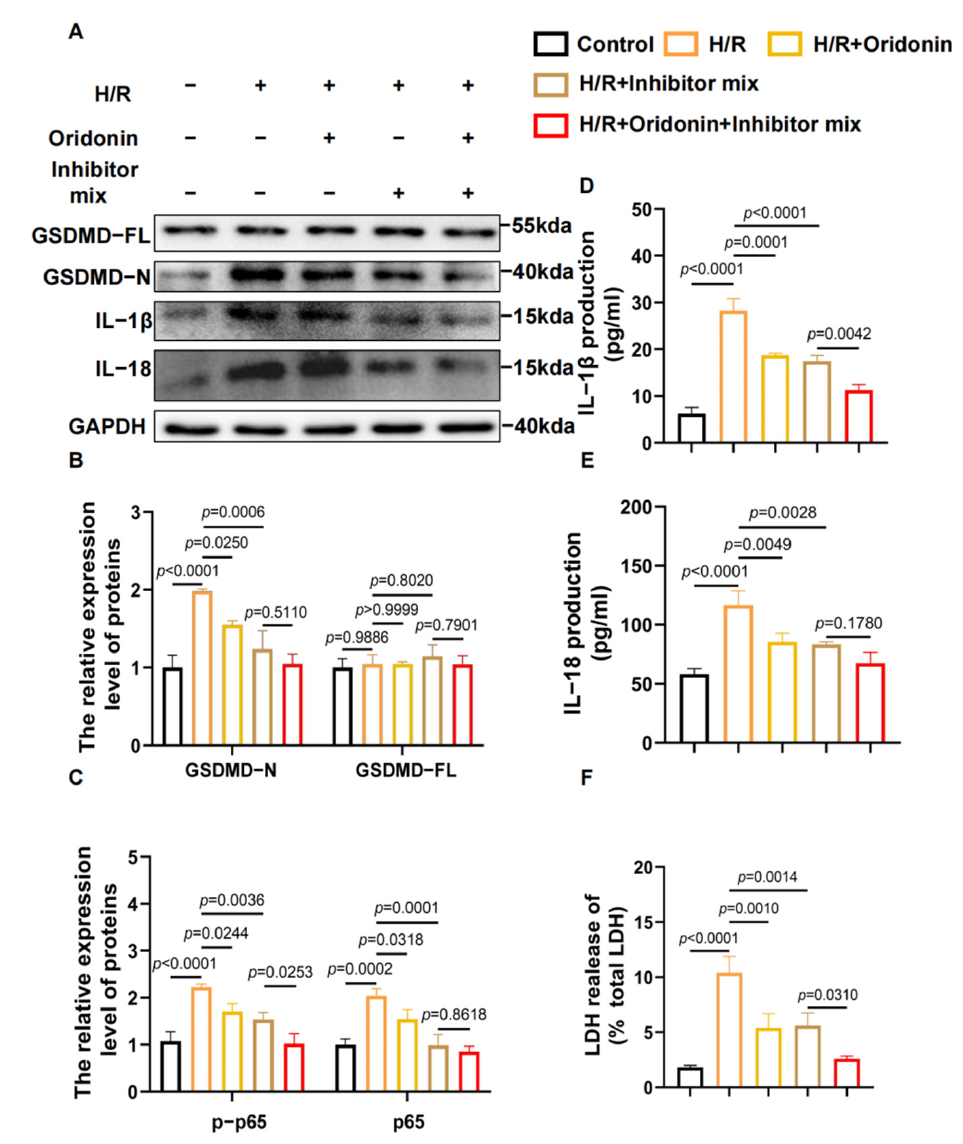
Figure 5. Oridonin regulated GSDMD-mediated cell pyroptosis via the NF- κ B/NLRP3 signaling pathway. ( A ) Representative western blot results of GSDMD-FL, GSDMD-N, IL-1 β and IL-18 from each group. ( B ) Densitometric quantification of GSDMD-N and GSDMD-FL based on ( A ). ( C ) Analy- sis of the densitometric measurements of IL-1 β and IL-18 based on ( A ). ( D ) Concentrations of IL-1 β in cell supernatants from each group. ( E ) Concentrations of IL-18 in cell supernatants from each group. ( F ) Concentrations of LDH in cell supernatants from each group. The protein level was standardized using GAPDH. The mixed inhibitor contained 5 µ M Bay-117082 (NF- κ B inhibitor), MCC950 (NLRP3 inhibitor) and VX-765 (caspase-1 inhibitor). All samples are from NRCMs. In all cases, the data are expressed as the mean ± SD.